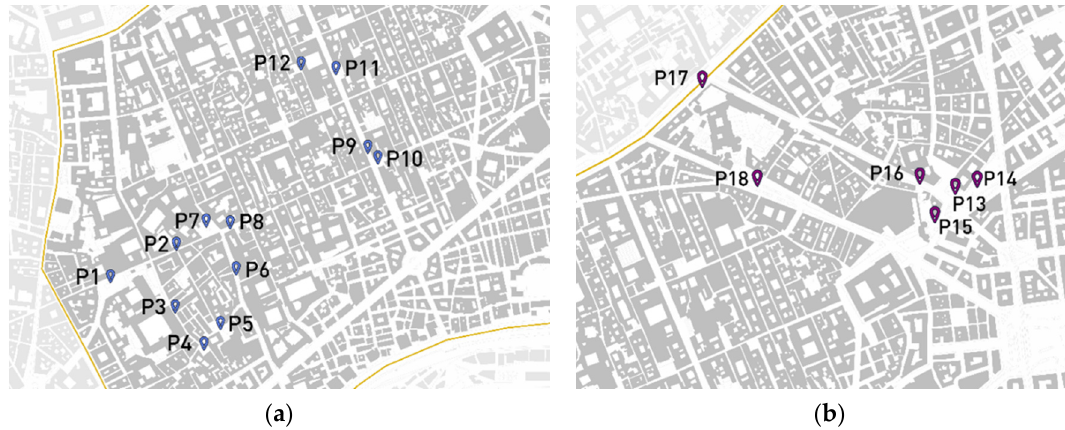
Figure A1. Location of the detected points during the survey of the environmental conditions of the Historic Centre of Naples: ( a ) 5 August 2014, h. 10:00–13:00 ( b ) 6 August 2014, h. 10:00–13:00.